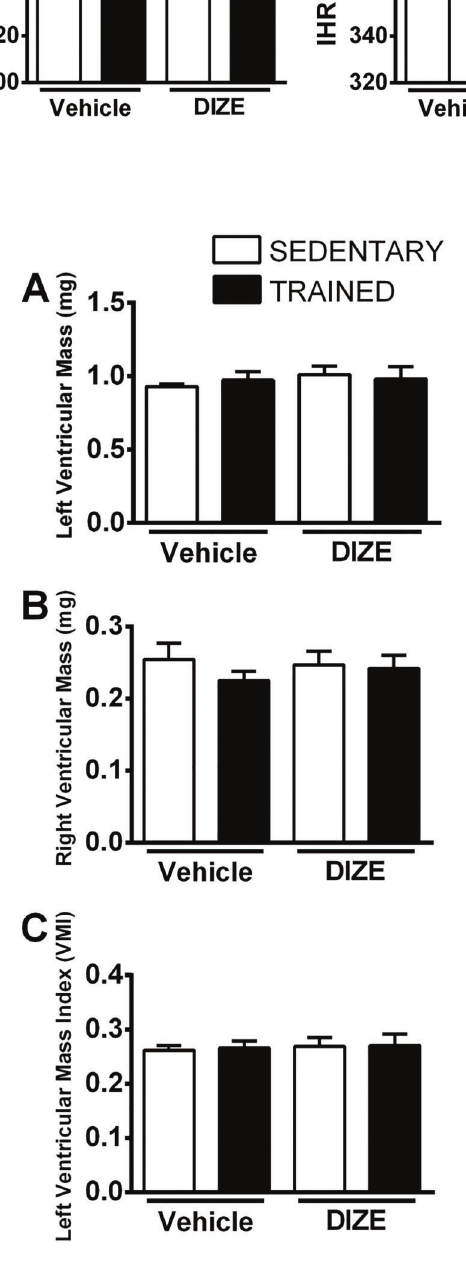
Figure 4. Means ± SE of left ventricular mass ( A ), right ventricular mass ( B ), and left ventricular mass index ( C ) of sedentary and trained groups receiving vehicle or diminazene aceturate